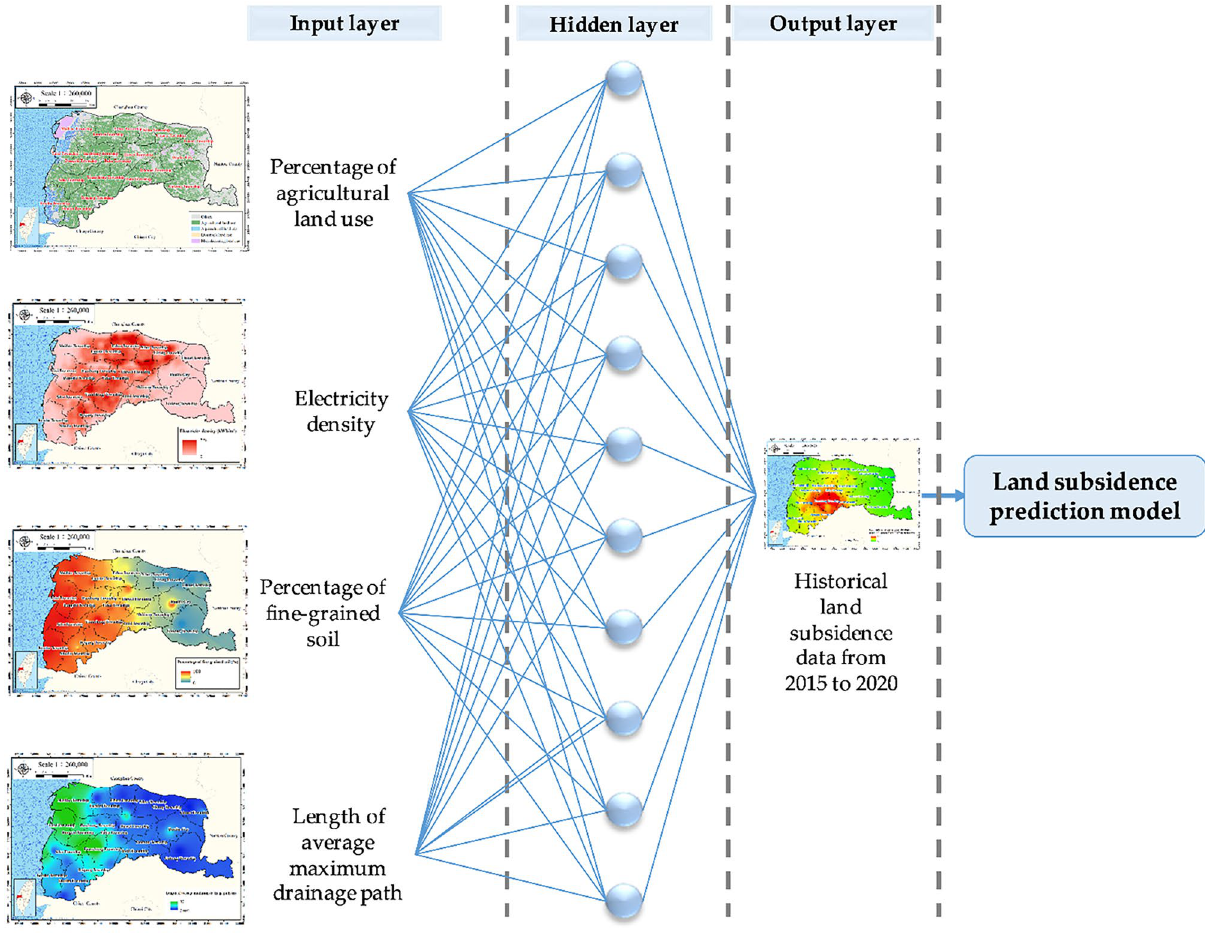
Figure 10. Proposed GIS-based ANN structure. This figure was created using ArcGIS 10.6.1